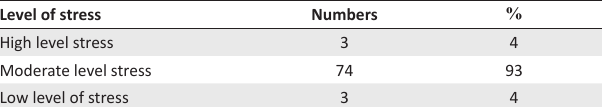
TABLE 6: Level of stress for incidence of stress.